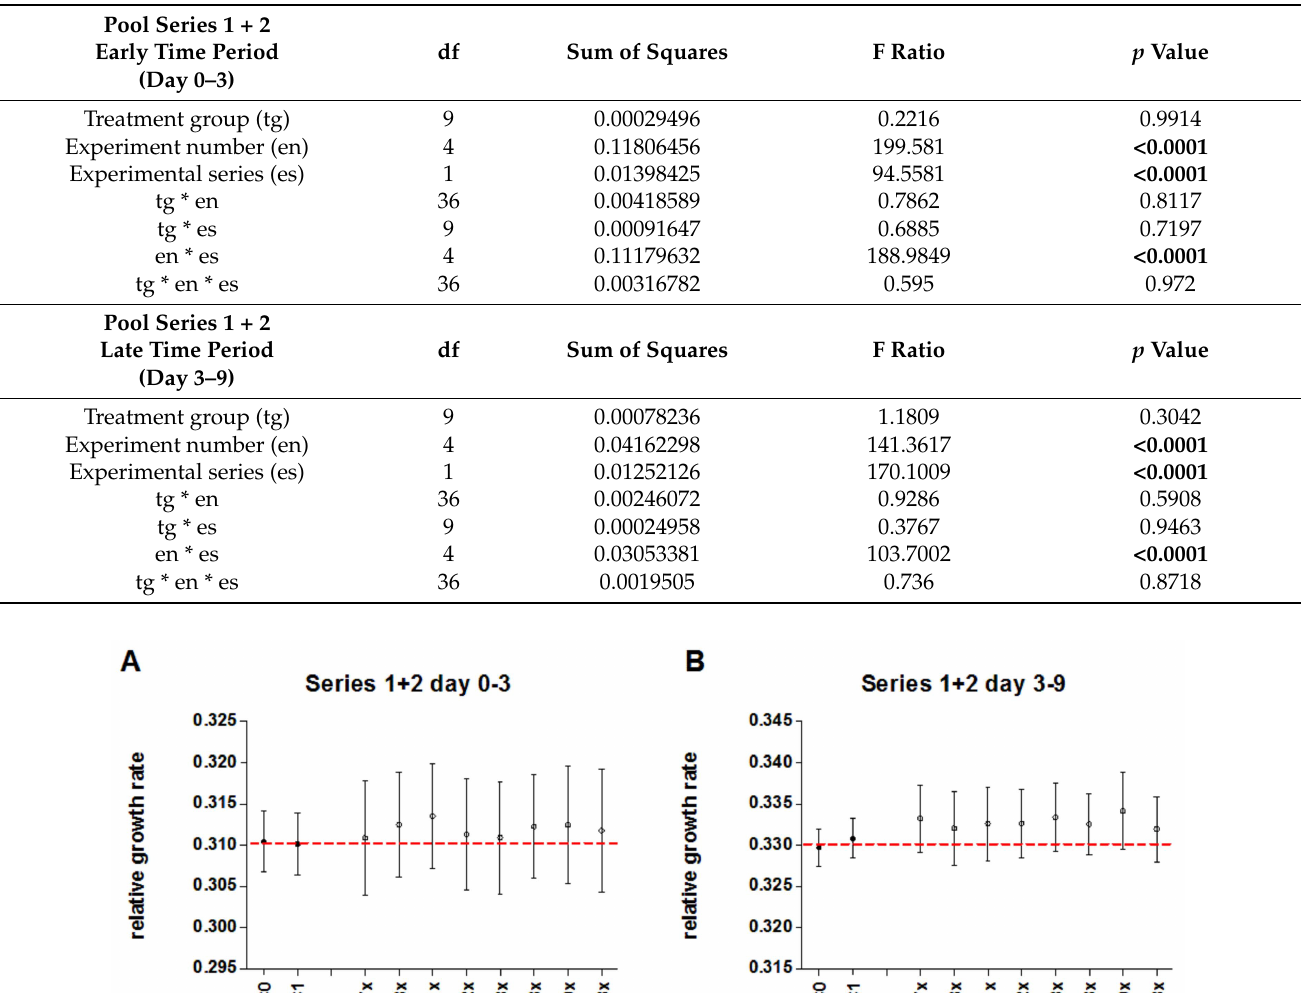
Table 8. Statistical analysis of series 1 and 2. Results of a three-way ANOVA for single treatment (As 2 O 3 17x–18x, 21x–23x, 28x, 30x, and 33x) and control (unsuccussed and succussed water) groups for n = 2 experimental series with n = 5 independent experiments, for the early (day 0–3) and late time period (day 3–9). df—degree of freedom. * = interaction between independent ANOVA factors. Significant values are printed bold.